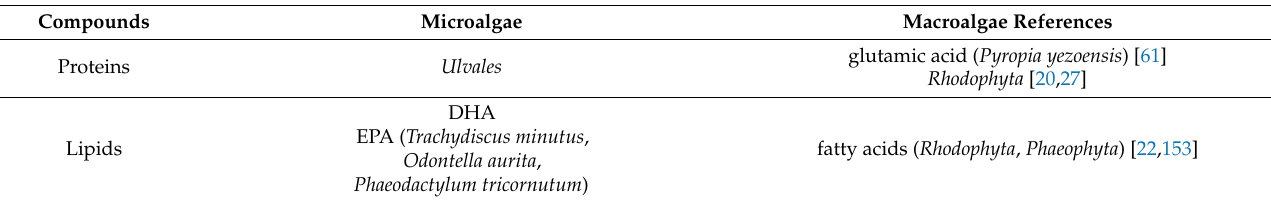
Table 2. Biologically active compounds extracted from micro- and macroalgae (seaweeds).